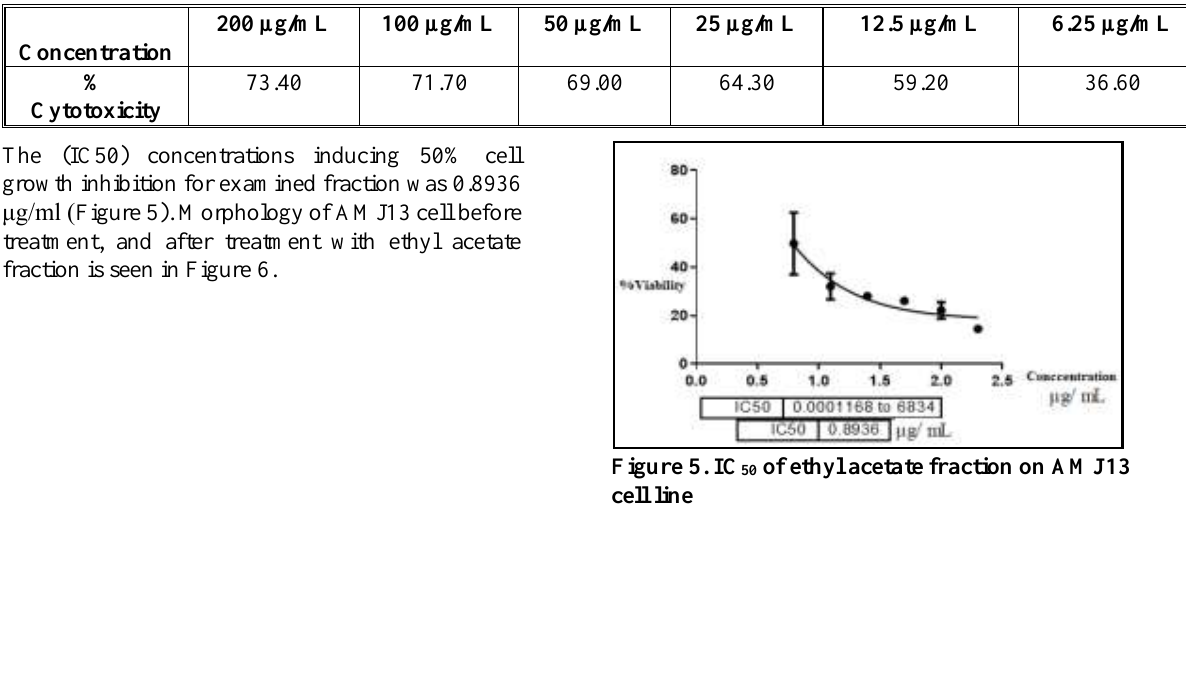
Table 2. % Cytotoxicity of ethyl acetate fraction at various concentration